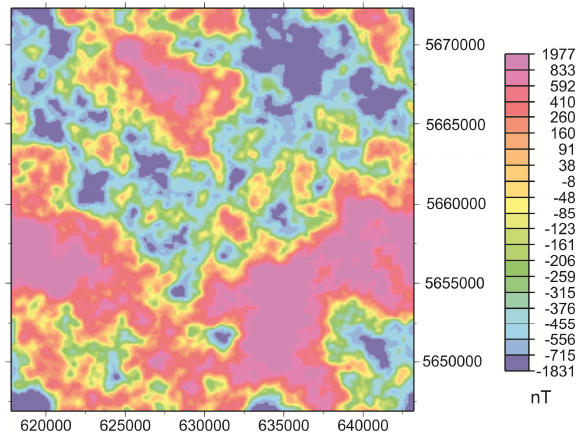
Fig. 4. Synthetic fractal grid extrapolated to rectangular edges after removal of fractal data located outside the survey area outline in blue in Fig. 1. Edges are zeros. Coordinates in metres are UTM zone 21.